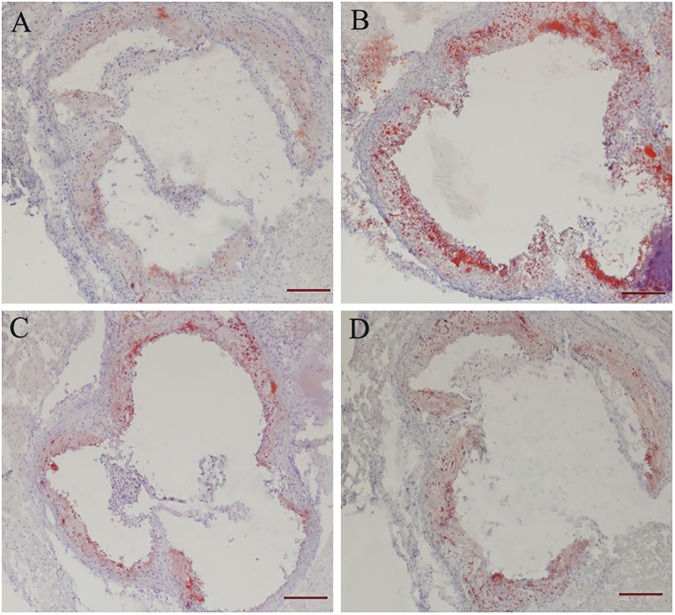
Oil red O staining of cross-sections of aortic roots in the hearts of ApoE-/- mice (n = 3 per group).(A) C57BL/Control; (B) ApoE-/-/Control; (C) ApoE-/-/GTP-L; (D) ApoE-/-/GTP-H (20× magnification).